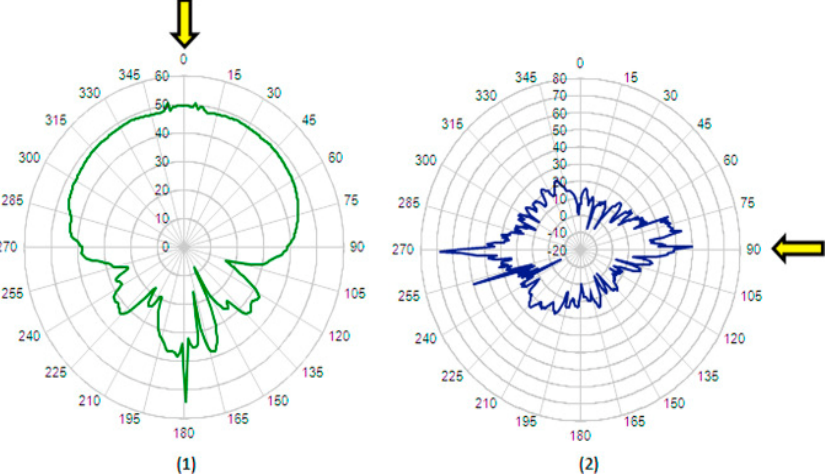
Figure 14. Illustration of the scattering outline by a particular case of the incident signal on a rotating turbine, showing the conditions and the coordinates of the blades, in which yellow arrows indicates the incidence direction. ( 1 ) Horizontal plane; and ( 2 ) the scattering arrays of the vertical plane [57]. Generally, (Figure 14), forward scattering from a blockade is greater than the backward scattering effect. The former is almost out of phase with the direct field, which resulted in a shadow at the back of the wind turbine [76].